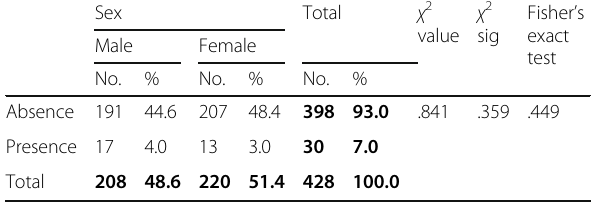
Table 1 Incidence of RMC according to number of patients Sex testMale